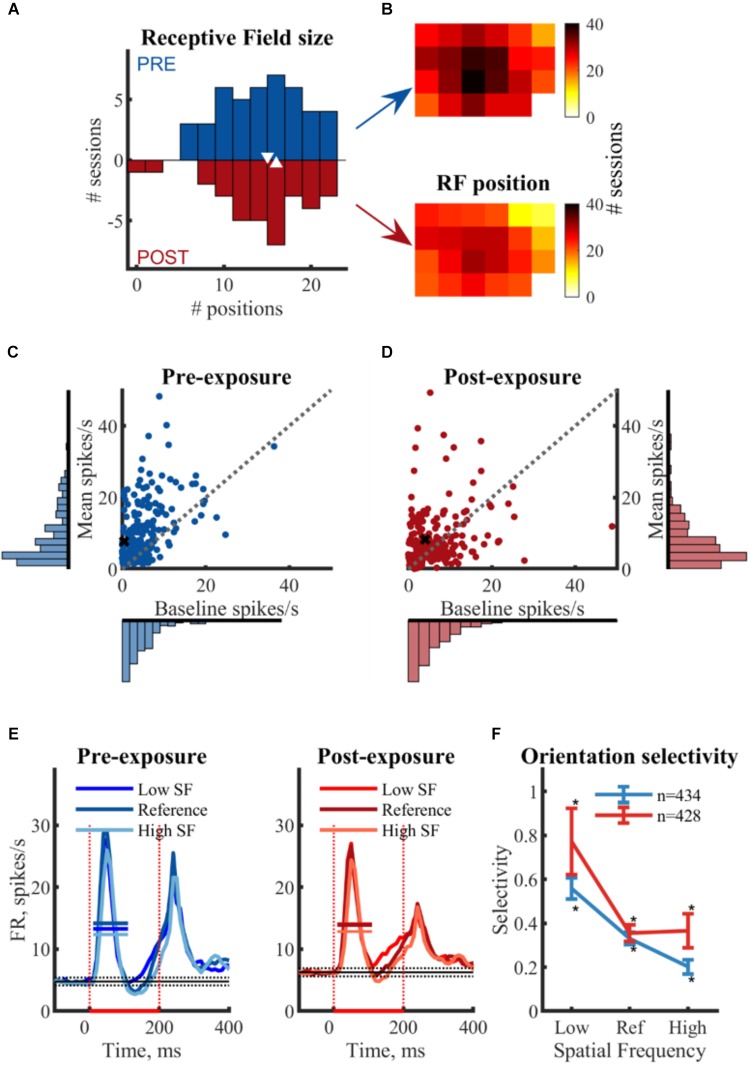
Comparison between pre- and post-exposure neural data in terms of basic functional properties. (A,B) Receptive field mapping of multi-unit responses. (A) Histogram of the RF sizes (bin size = 2) per session with median values (). RF size is expressed as the amount of screen positions with a significant MU response (p < 0.05 one-sided t-test from BL). (B) Position of the MU RFs on screen. Each square represents one screen position of the flashing square. Color bar indicates the number of sessions a specific screen positions was significantly response. The bottom right corner of the screen is covered by a photocell to detect stimulus presentation and is thus not sampled during RF mapping. (C,D) Baseline and mean response in spikes/s: Scatterplots and associated histograms (bin size = 2 ms) represent the baseline and mean (BL corrected) responses per SU. Each dot represents the average response of one SU across all stimuli. X indicates example SUs as in Figure 3. No differences in distribution between pre- and post-exposure is observed, indicating both groups of SU’s come from a similar neural population. (E) Temporal response characteristics: the mean (±SEM) PSTH for all responsive and selective SUs per SF for both pre- and post-exposure. — mean response FR;  stimulus ON;  baseline response (mean ± 3∗SEM). (F) Dependence of orientation selectivity on spatial frequency: mean (±SEM) selectivity per SF for pre- and post-exposure SUs. Selectivity is calculated as the difference in normalized responses between two orientations of the same SF. Includes all SUs with significant selectivity to at least one SF, thus removing the selection bias for SUs with a strong selectivity at the reference SF. ∗
t-test from 0, p < 0.05.